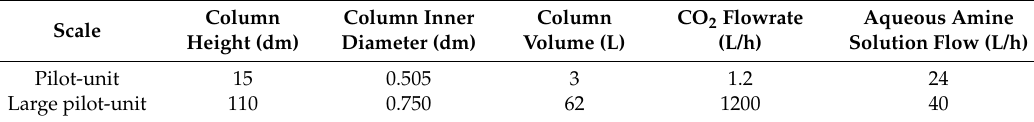
Table 1. Dimensions of the absorption column used for the different